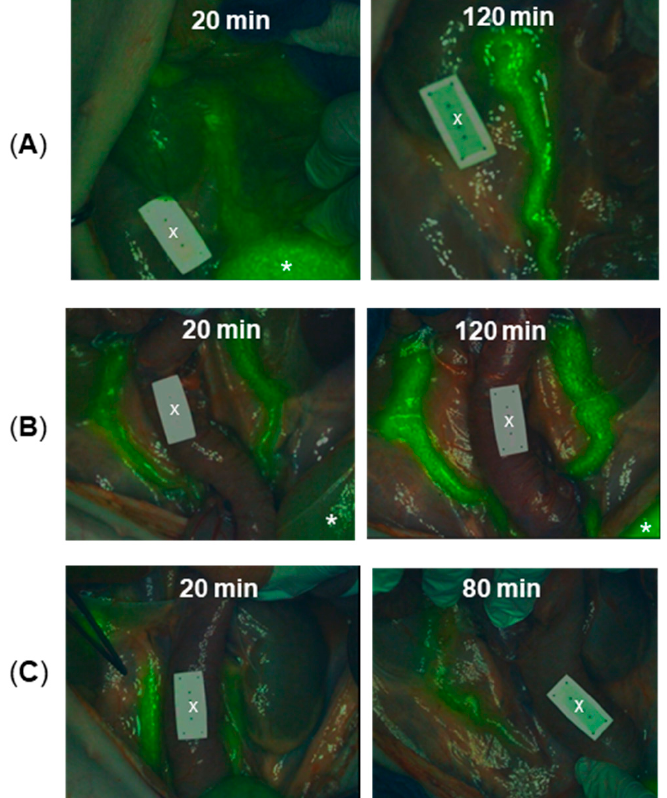
Figure 8. Porcine ureter identification following administration of differing dosages of 12 and at different time points ( n = 6). (A) Images at 20 and 120 min following the administration of 0.5 mg/kg dose. (B) Images at 20 and 120 min following the administration of 0.25 mg/kg dose.(C) Images at 20 and 80 min following the administration of 0.1 mg/kg dose. * Indicates the bladder. X Indicates non-fluorescent ICG reference card. For other representative images see Figure S8.